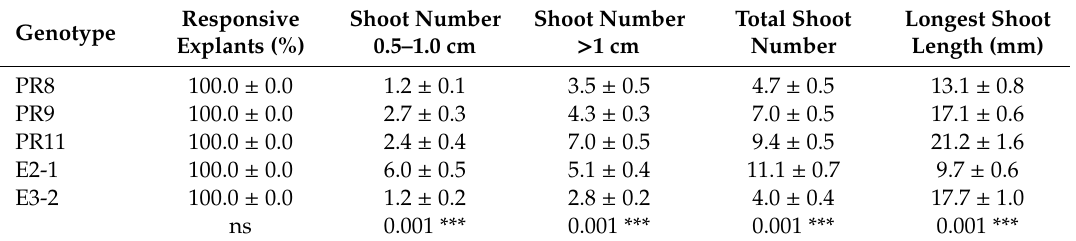
Table 2. Influence of genotype on shoot proliferation in cultures derived from five tolerant Quercus ilex genotypes.